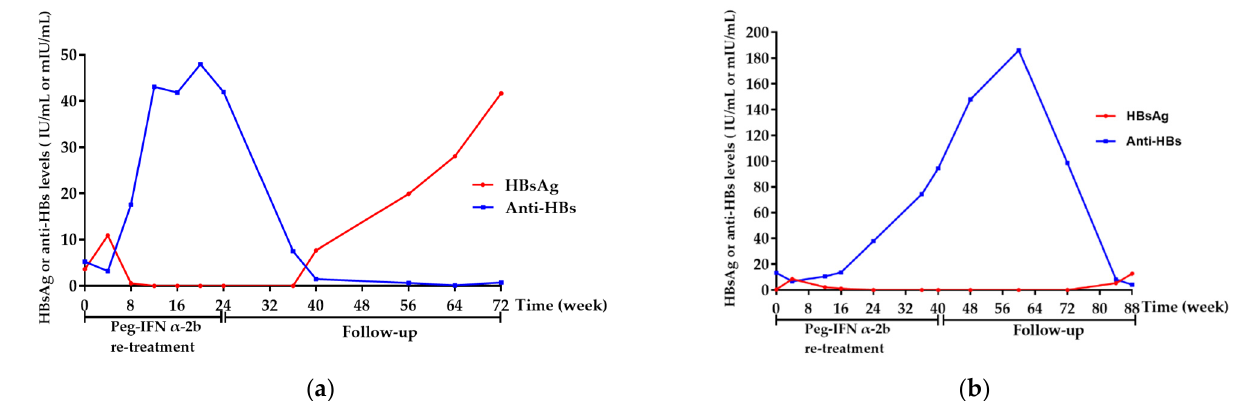
Figure 4. Dynamics of HBsAg and anti-HBs of the two patients with HBsAg recurrence again. (a) Dynamics of HBsAg and anti-HBs of the female (No. 5) patient. (b) Dynamics of HBsAg and anti-HBs of the male (No. 6) patient. Week 0 was defined as the time when the patients were enrolled in this study. Abbreviations: HBsAg, hepatitis B surface antigen; anti-HBs, hepatitis B surface antibody; Peg-IFN- α , peginterferon alpha.